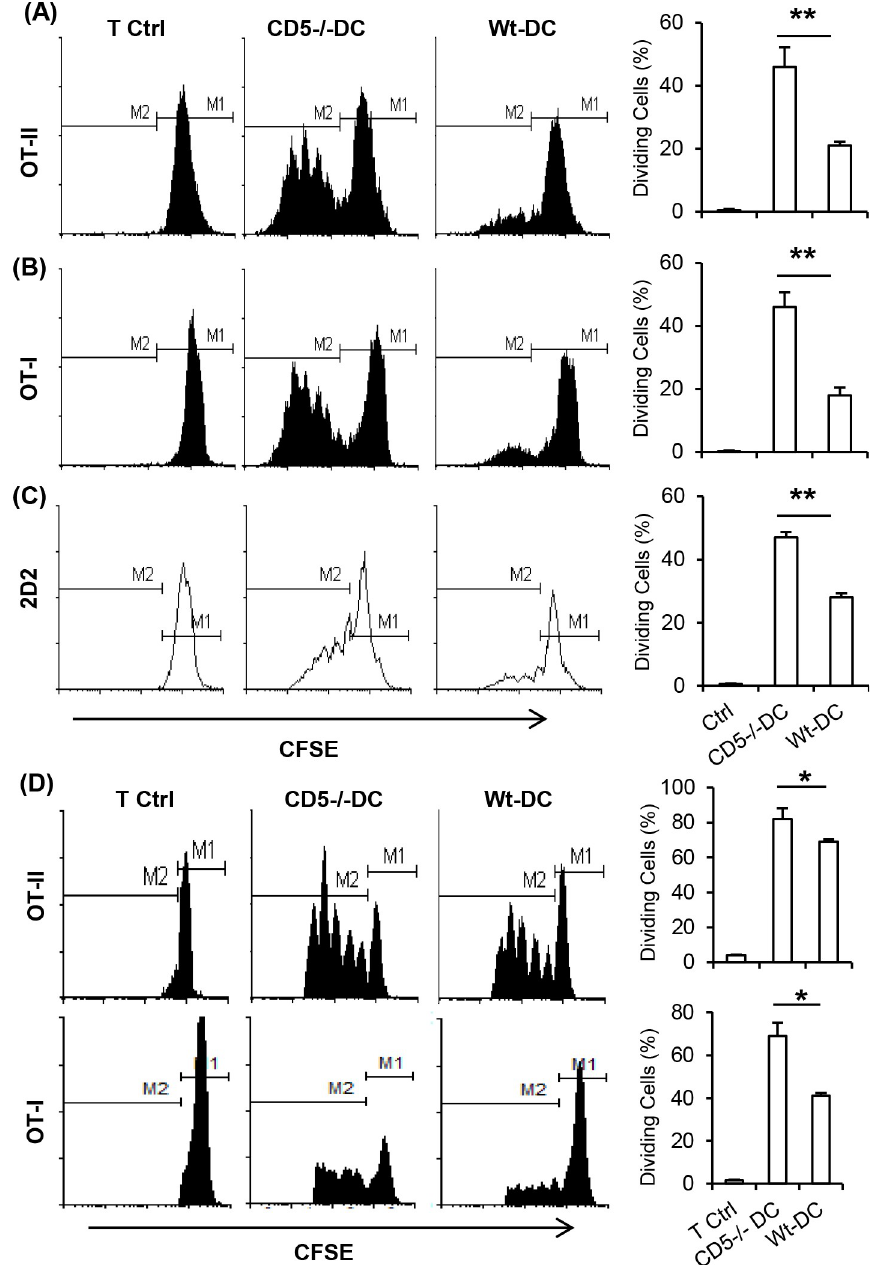
Fig 3. CD5 deficiency enhances the capacity of DC to activate CD4+ and CD8+ T cells. OT-II (A) or OT-I (B) cells were cultured with OVA peptides pulsed BMDC. The cultures without OVA peptides served as controls (T Ctrl) (n = 5). (C) CD4+ T cells from 2D2 mice were stimulated with CD11c+ SP DC from WT or CD5 -/- mice in the presence of MOG 35-55 peptide (n = 5). (D) Na ï ve WT mice were injected subcutaneously with OVA peptides pulsed BMDC into rear footpads followed by intravenous injection of CFSE labeled OT-II or OT-I cells. Control mice received CFSE labeled T cells but no DC (Ctrl). The draining popliteal LN were analyzed (n = 6). The data are representative of 3–5 independent experiments (two-tailed Student’s t -test, � P < 0.05, �� P <